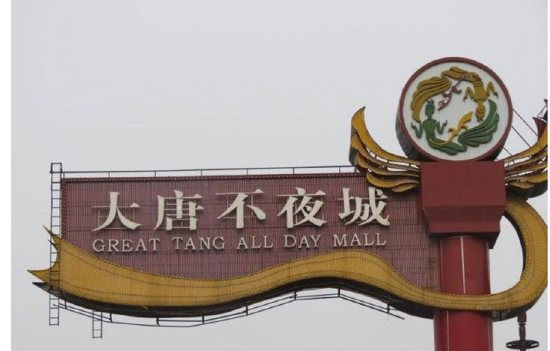
Fig. 1 A billboard for the Great Tang All Day Mall in the Qujiang District of Xi’an, 2016 (Source: the author)